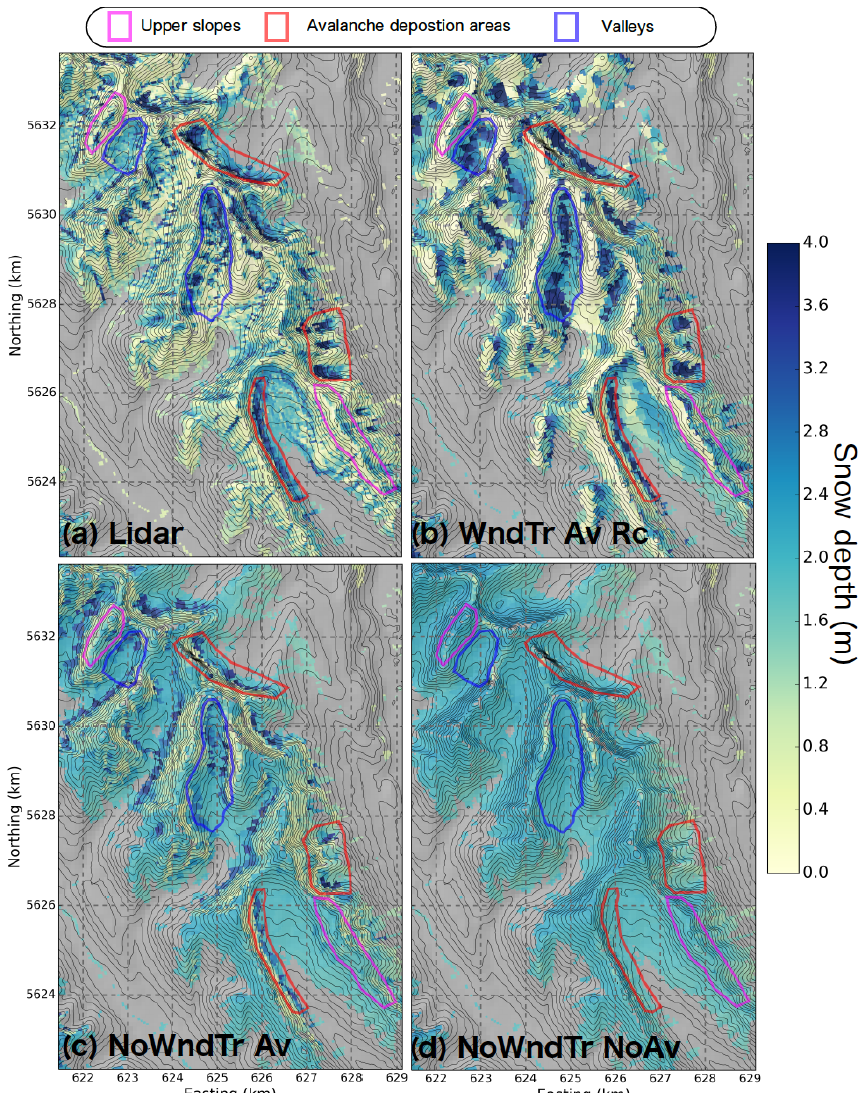
Figure 6. Snow depth on 27 April 2018 (a) measured by ALS and simulated by three CHM configurations: (b) WndTr Av Rc, (c) NoWndTr Av and (d) NoWndTr NoAv (Table 3). Properties of snow depth distribution in areas with coloured contours are discussed in the text. Pixels covered by tall vegetation in the observations and in the simulations are excluded from the comparison and appear in grey. Black isolines correspond to (cid:49) z = 50m, and the location of this region is shown in Fig.